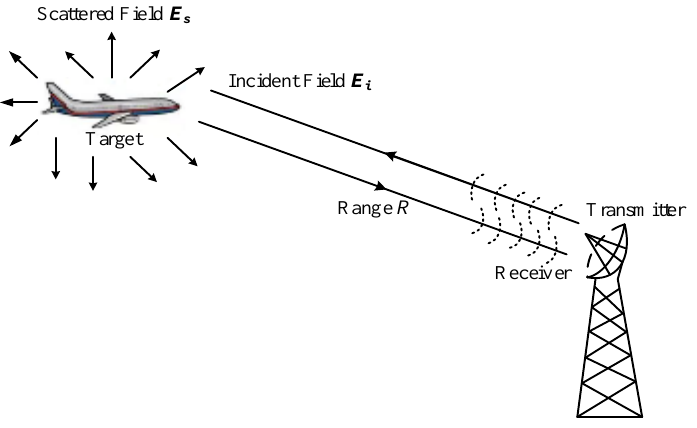
Figure 1. A sketch picture of the radar cross section (RCS) concept.